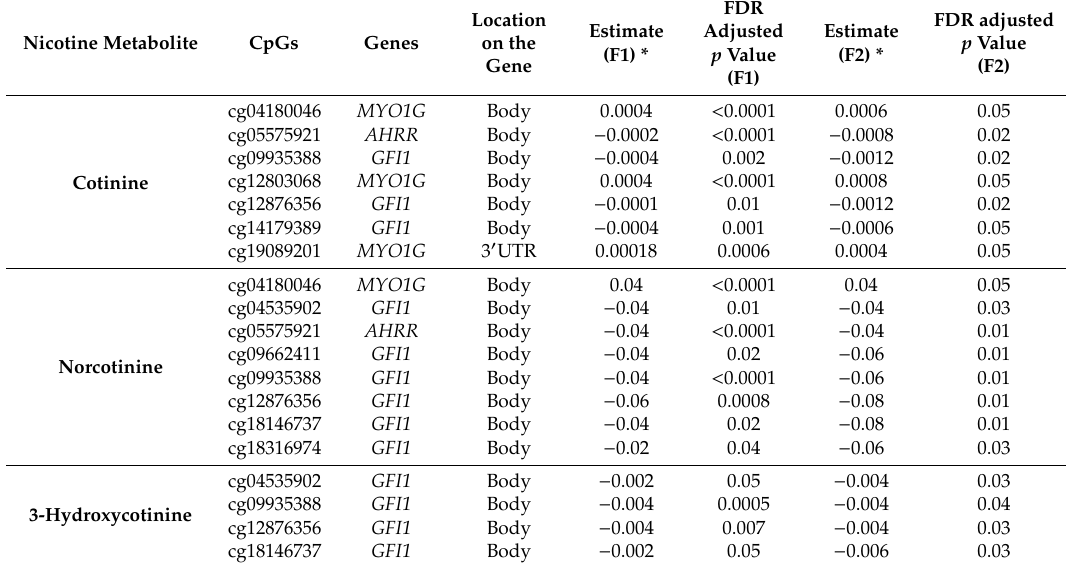
Table 6. CpGs and their linked genes linked statistically significantly associated with nicotine metabolites in maternal (F0 mothers of F1) and cord (F2) sera (discovered by Joubert et al. [16], tested in the F1 and replicated in the F2